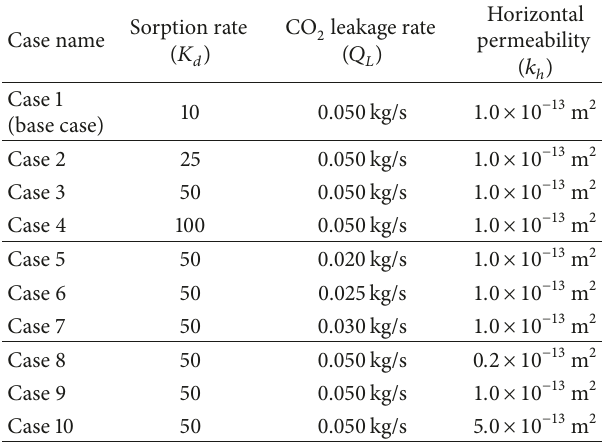
Table 6: Different parameters for sensitivity studies. Three groups except Case 1 (base case) are designed for sorption rate ( 𝐾 𝑑 ) (Cases 2–4), gaseous CO 2 leakage rate ( 𝑄 𝐿 ) (Cases 5–7), and horizontal permeability ( 𝑘 ℎ ) (Cases 8–10),